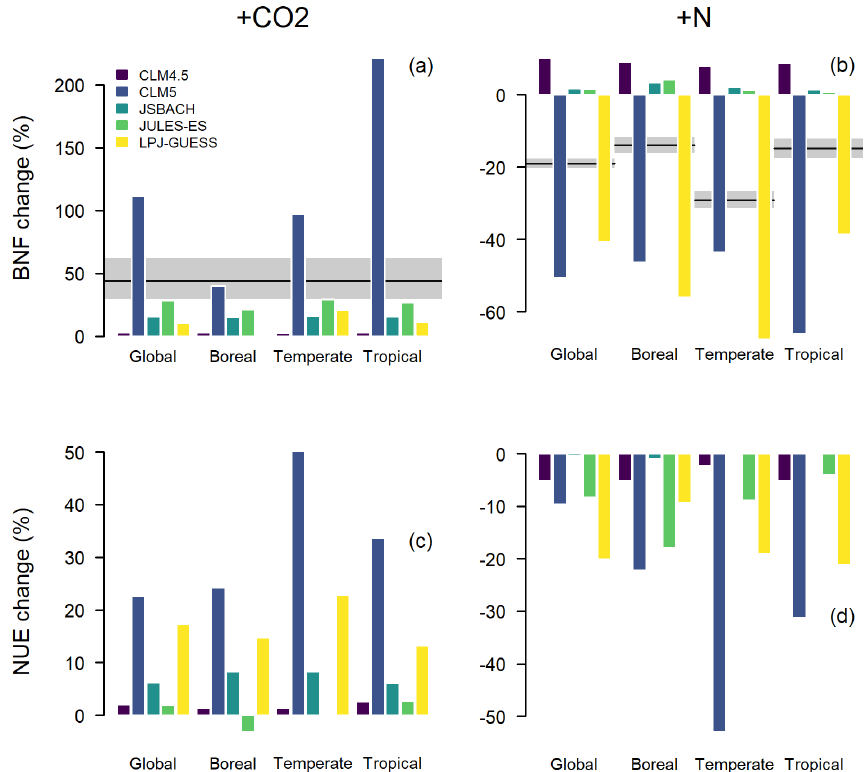
Figure 7. Averaged 1996–2005 responses in biological nitrogen fixation (BNF) and nitrogen-use efficiency (NUE; see Eq. 1) to + CO 2 and + N perturbations for the global (all vegetation types) or forest region averages. (a) Model BNF responses to + CO indicate mean and 95% CI, respectively, of the global estimate published by Liang et al. (2016). (b) Model BNF responses to + N. Black lines and grey areas indicate means and 95% confidence intervals, respectively, of the forest estimates published by Zheng et al. (2019). (c) Model NUE responses to + CO 2 . (d) Model NUE responses to + N. Forest biomes are according to the Köppen–Geiger climate classification (Kottek et al., 2006); see Fig.